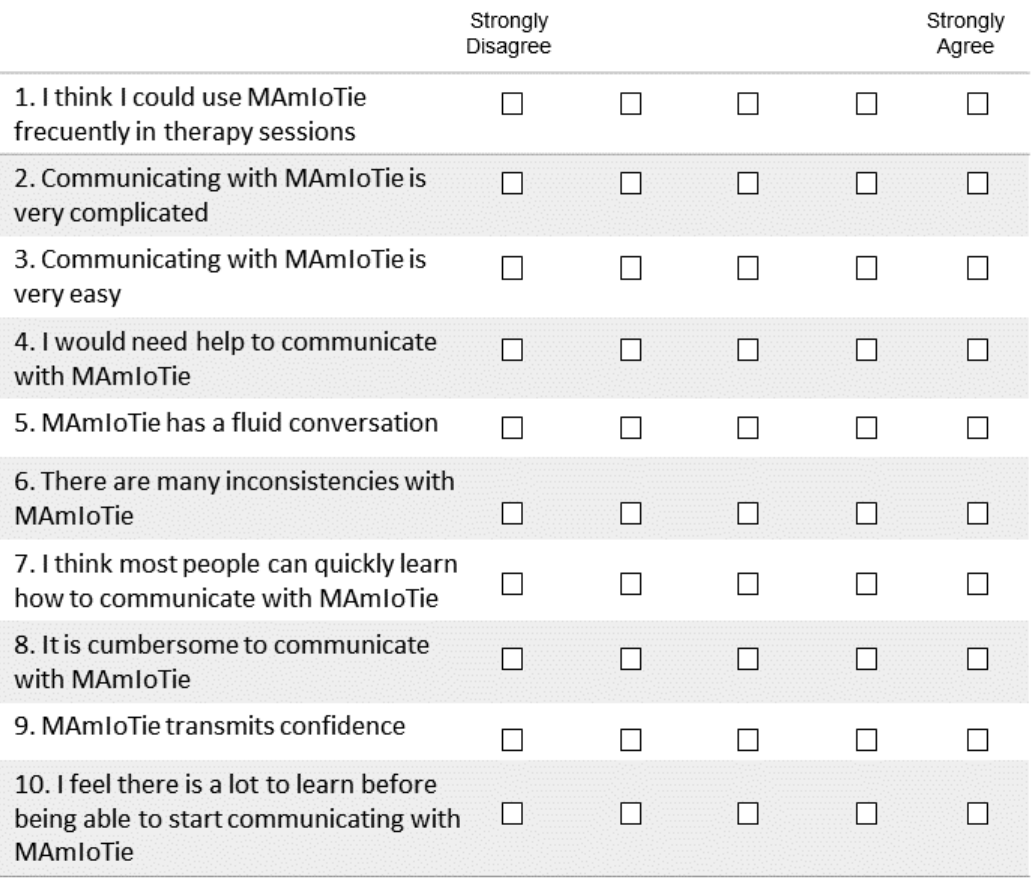
Figure A1. This questionnaire follows the system usability scale model, adapted to find out the information that is pertinent to MAmIoTie. Question 1 is the one that differs the most from the standard question, and it states, “I think that MAmIoTie could be used frequently in therapy sessions”. This question was changed, as it aligned exactly with the goals we are trying to achieve, and the knowledge we were hoping to obtain.